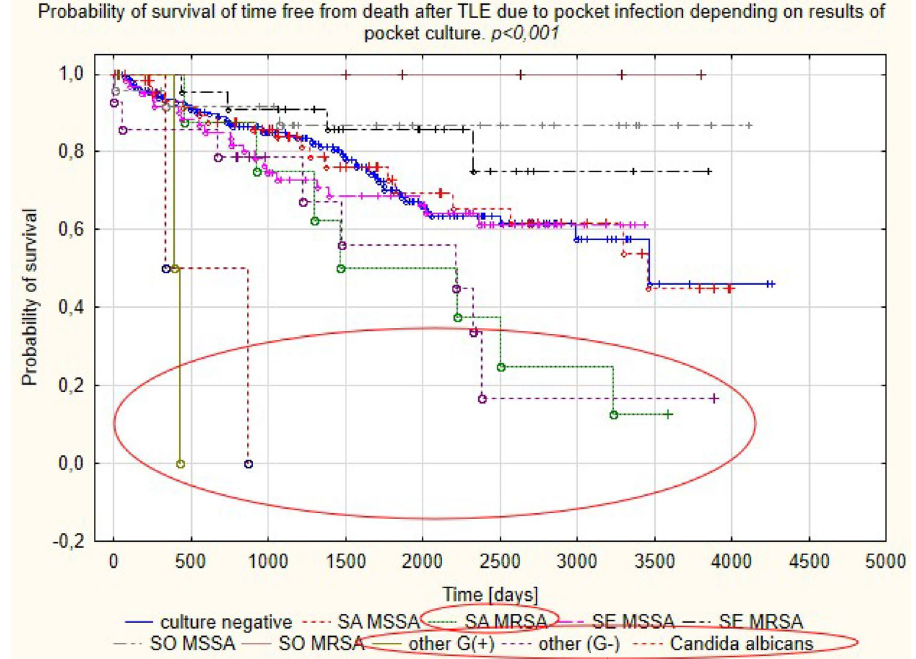
Figure 5. Probability of survival in patients with PI depending on pathogen type.